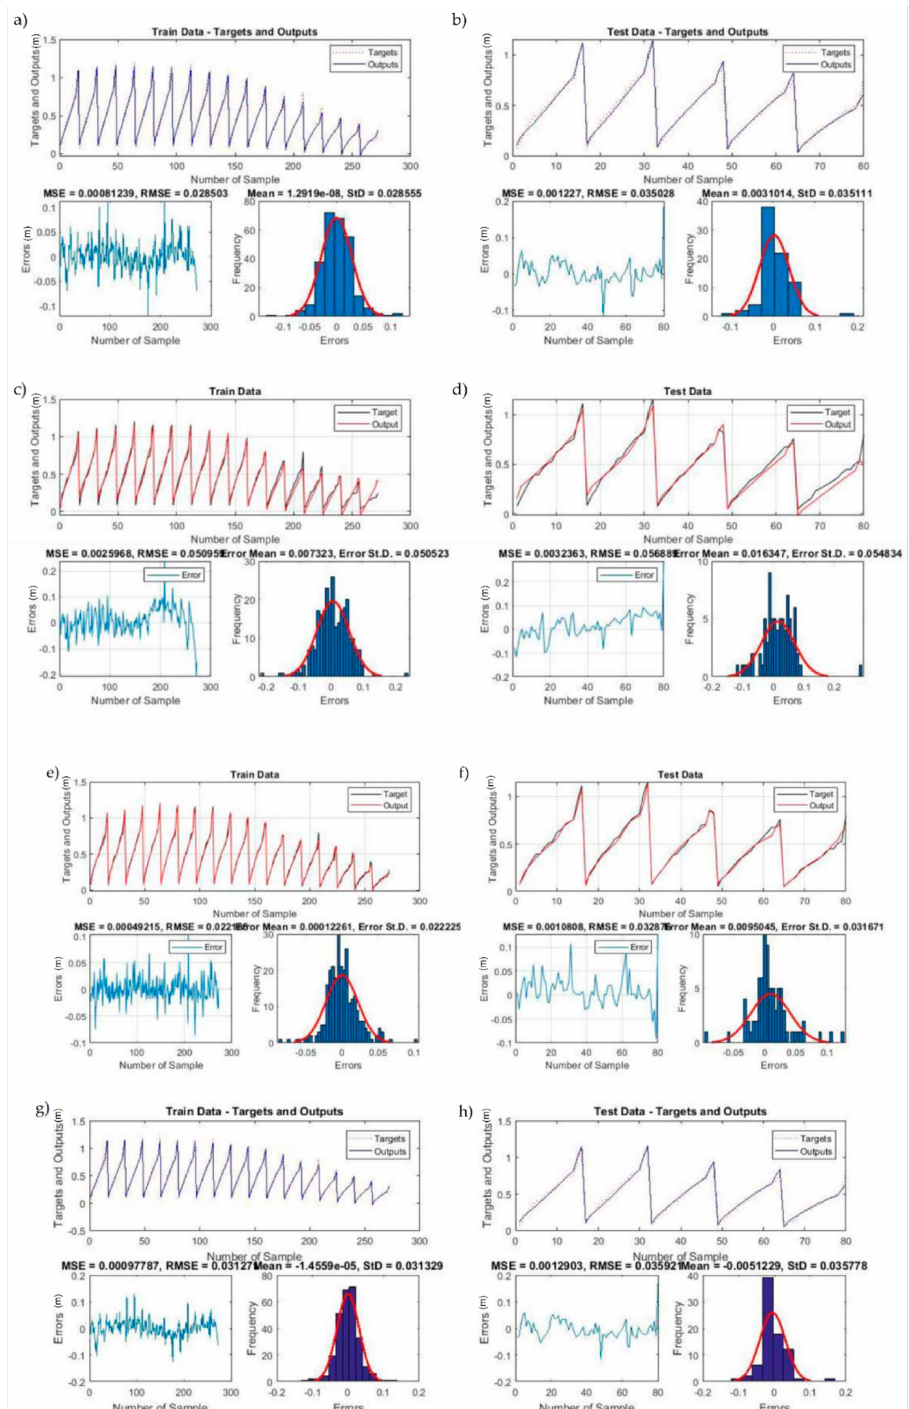
Figure 10. For output x r , ANFIS Model ( a ) targets and outputs, RMSE, MSE values and frequency vs. errors graphs for train data set ( b ) targets and outputs, RMSE, MSE values and frequency vs. errors graphs for test data set. ANFIS-GA: ( c ) targets and outputs, RMSE, MSE values and frequency vs. errors graphs for train data set ( d ) targets and outputs, RMSE, MSE values, and frequency vs. errors graphs for test data set. ANFIS-PSO: ( e ) targets and outputs, RMSE, MSE values and frequency vs. errors for train data set ( f ) targets and outputs, RMSE, MSE values, and frequency vs. errors for test data set. ANFIS-FFA: ( g ) targets and outputs, RMSE, MSE values and frequency vs. errors for train data set ( h ) targets and outputs, RMSE, MSE values, and frequency vs. errors for test data